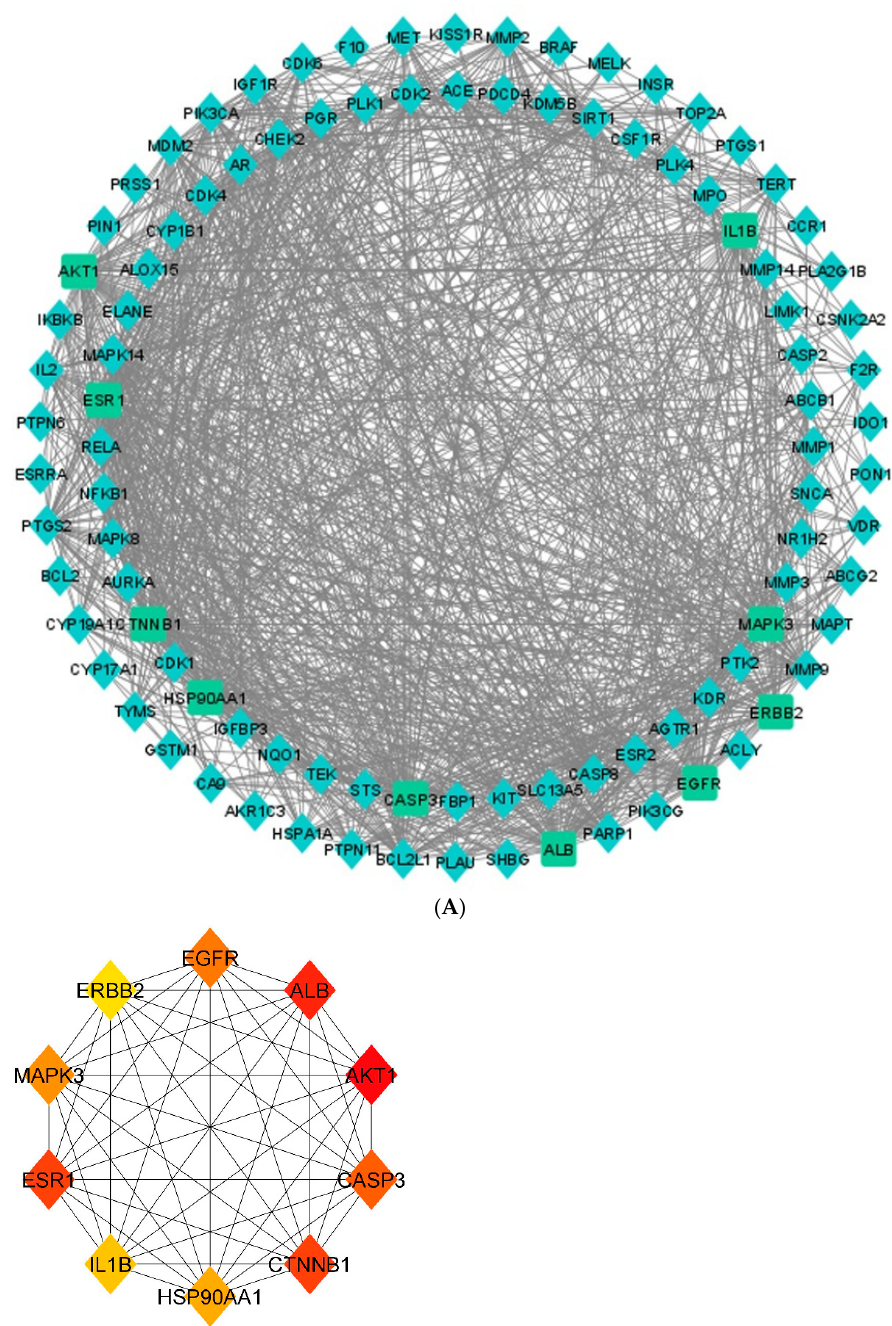
Figure 4. ( A ) Analysis and Visualization of PPI network in Cytoscape. ( B ) Top 10 targets of C. fistula on EOC analyzed by Cytoscape.